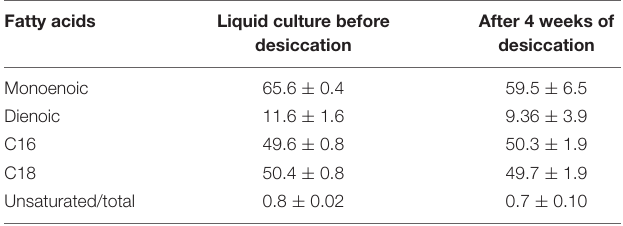
TABLE 1 | Percentage content of fatty acid of Gloeocapsopsis sp. UTEXB3054 during desiccation. Fatty acids